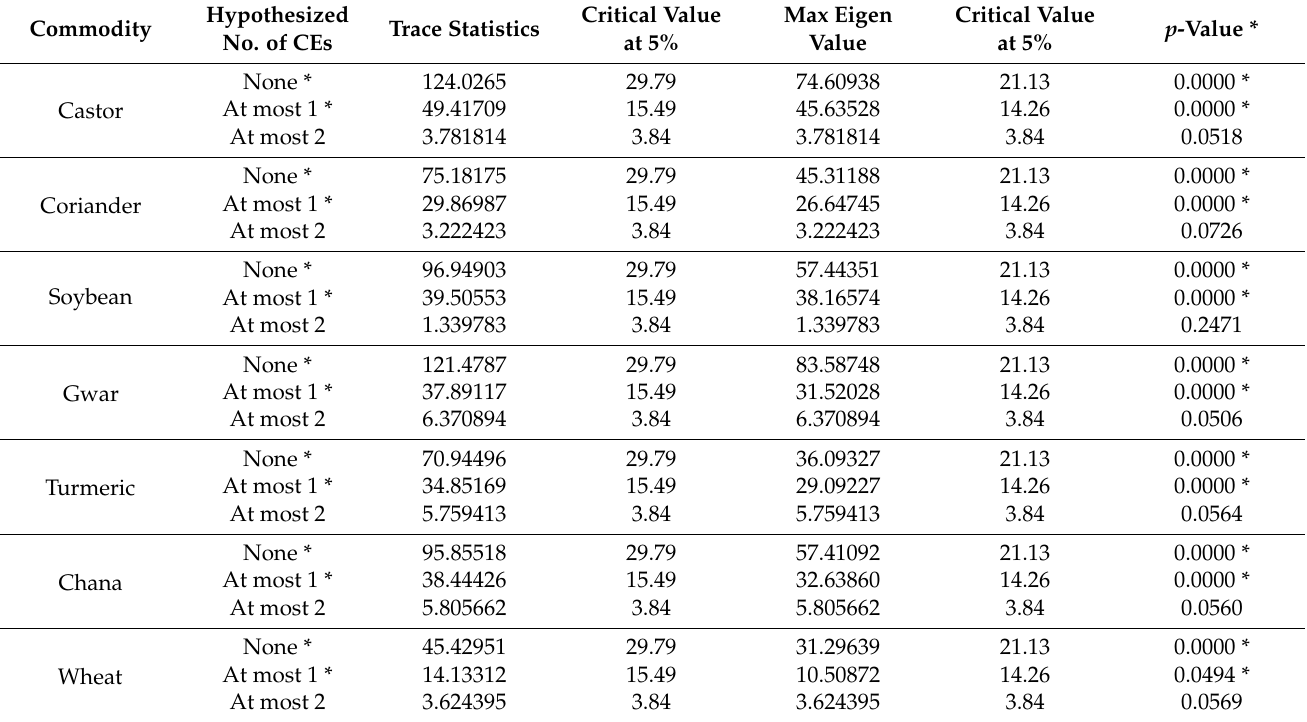
Table 2. Results of Johansen Cointegration